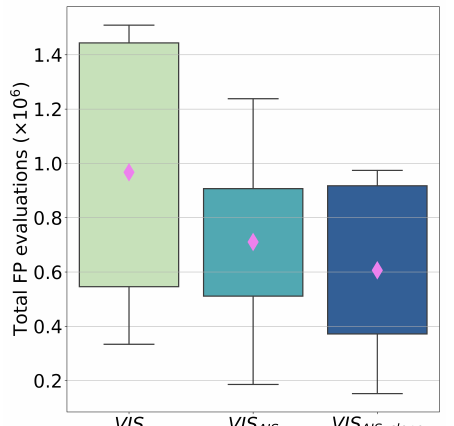
Figure 8. Box plot of the total FP executions in the 30 runs of the three tested approaches. The pink diamonds represent the mean value of each